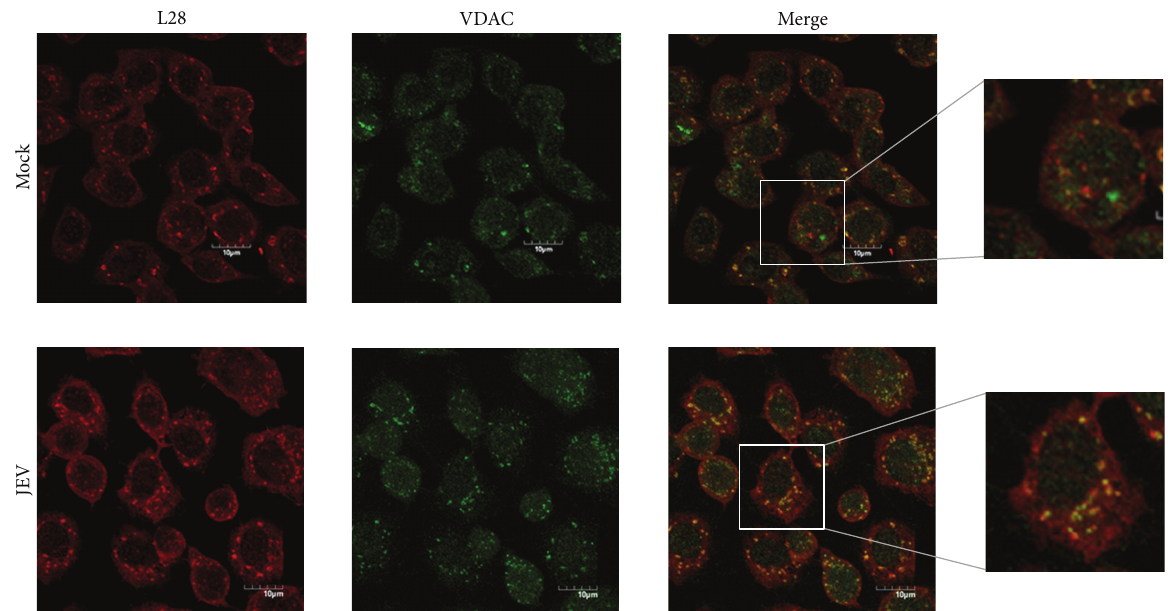
Figure 6: Location of JEV E protein, VDAC, and ribosomal L28 protein in JEV infected C6/36 cells. Signal of VDAC and ribosomal L28 protein extracted from Figure 5 for improved visualization purposes with